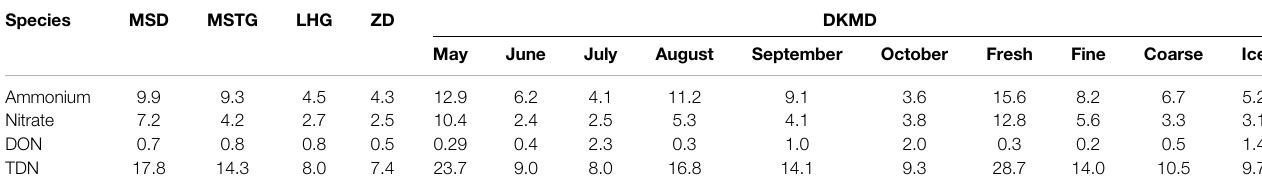
Species MSD MSTG LHG ZD